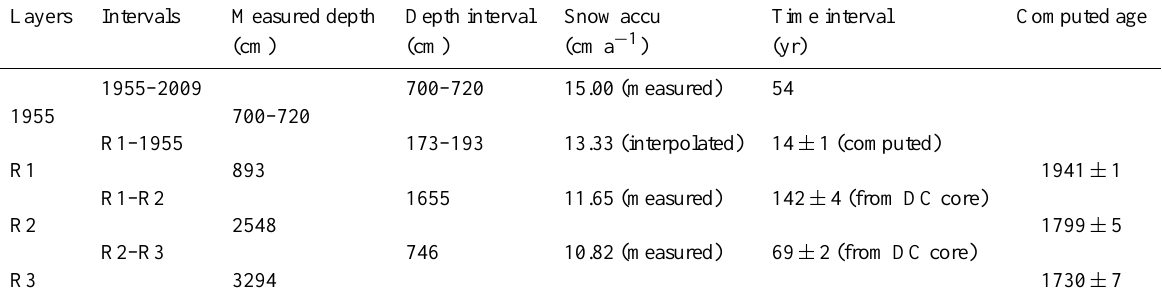
Table 4. Summary of the parameters which were measured or computed at F4 to calculate ages, and ensuing computed age for each